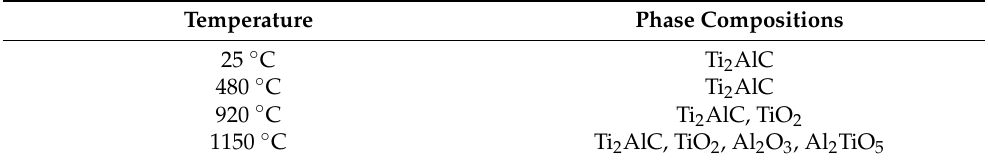
Table 3. Phase compositions of the sample’s surface of water-quenched Ti 2 AlC ceramic heated in air at different